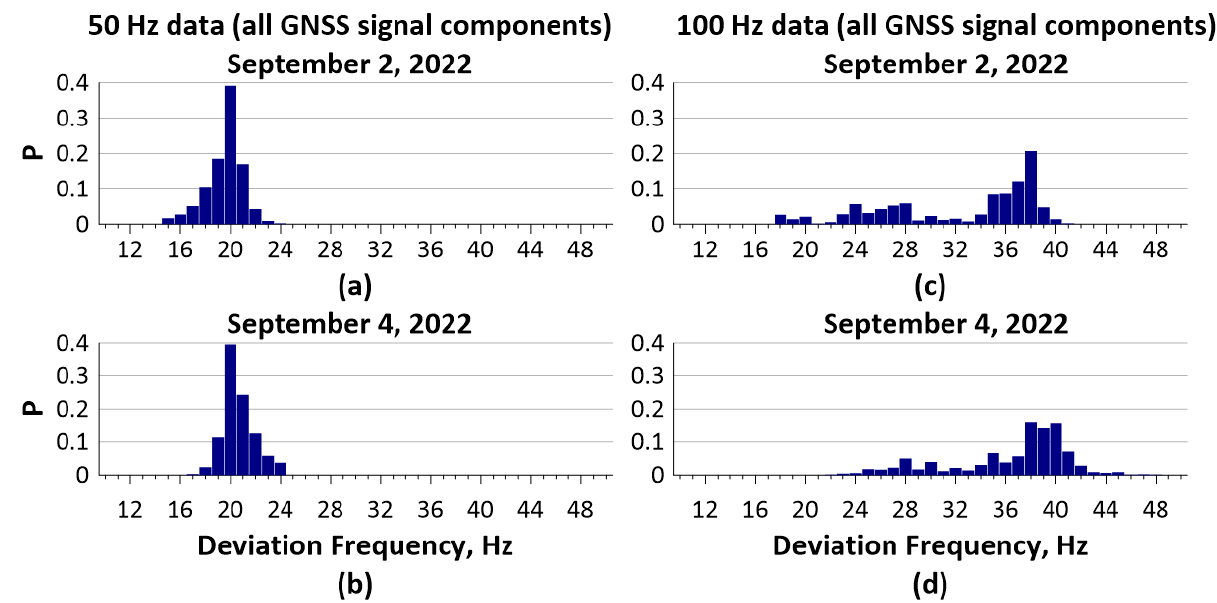
Figure 5. The deviation frequency distribution obtained from 50 Hz ( a , b ) and 100 Hz ( c , d ) data of all GNSS signal components by Septentrio receiver under quiet conditions ( a , c ) and under magnetic storm ( b , d ).